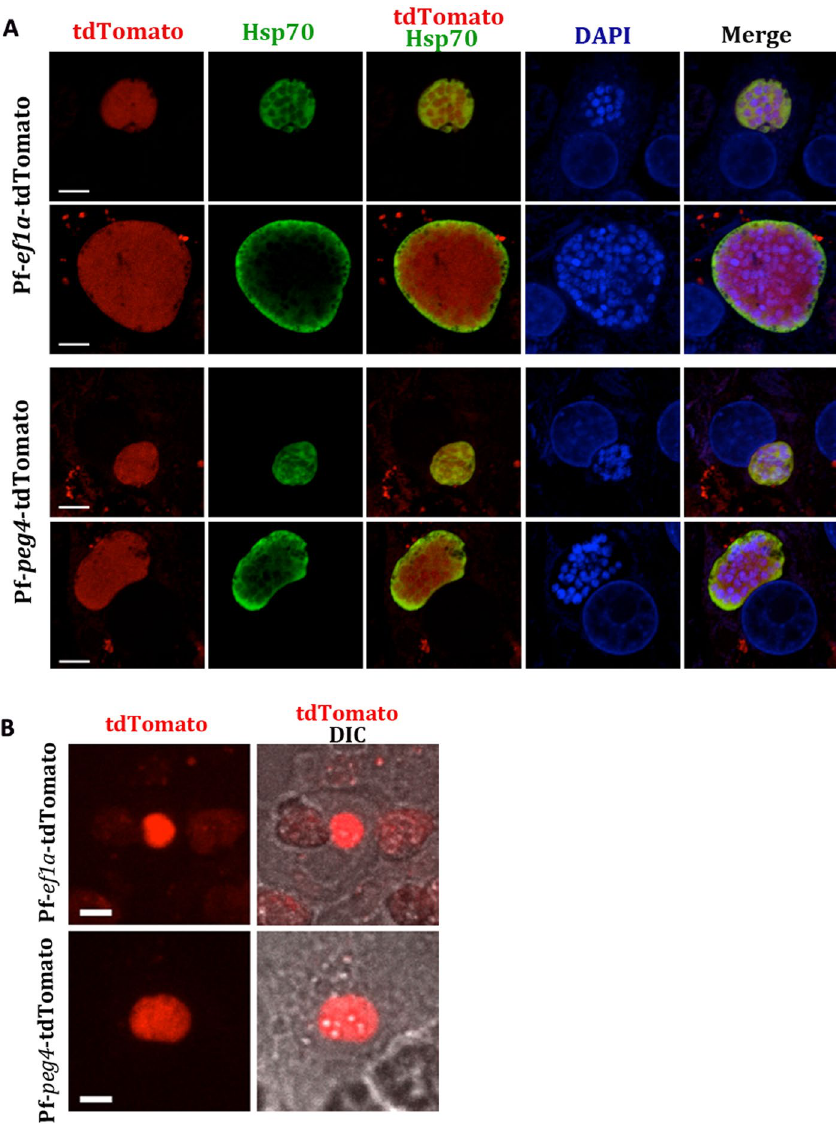
Figure 4. Immunofluorescene assays of late liver stage P . falciparum -tdTomato lines. ( A ) Primary human hepatocytes were infected with Pf- peg4 -tdTomato and Pf- ef1 α -tdTomato sporozoites. At 96 hours post infection, cells were fixed and stained for PfHsp70 (green) to visualize the parasite cytoplasm together with the endogenous tdTomato fluorescence (red). DNA was stained with DAPI (blue). Scale bars 5 μ m. ( B ) Live confocal microscopy of Pf- peg4 -tdTomato and Pf- ef1 α -tdTomato EEFs at 96 hours post infection of primary human hepatocytes. Fluorescent images and overlays with the DIC images are shown. Scale bars 15 μ